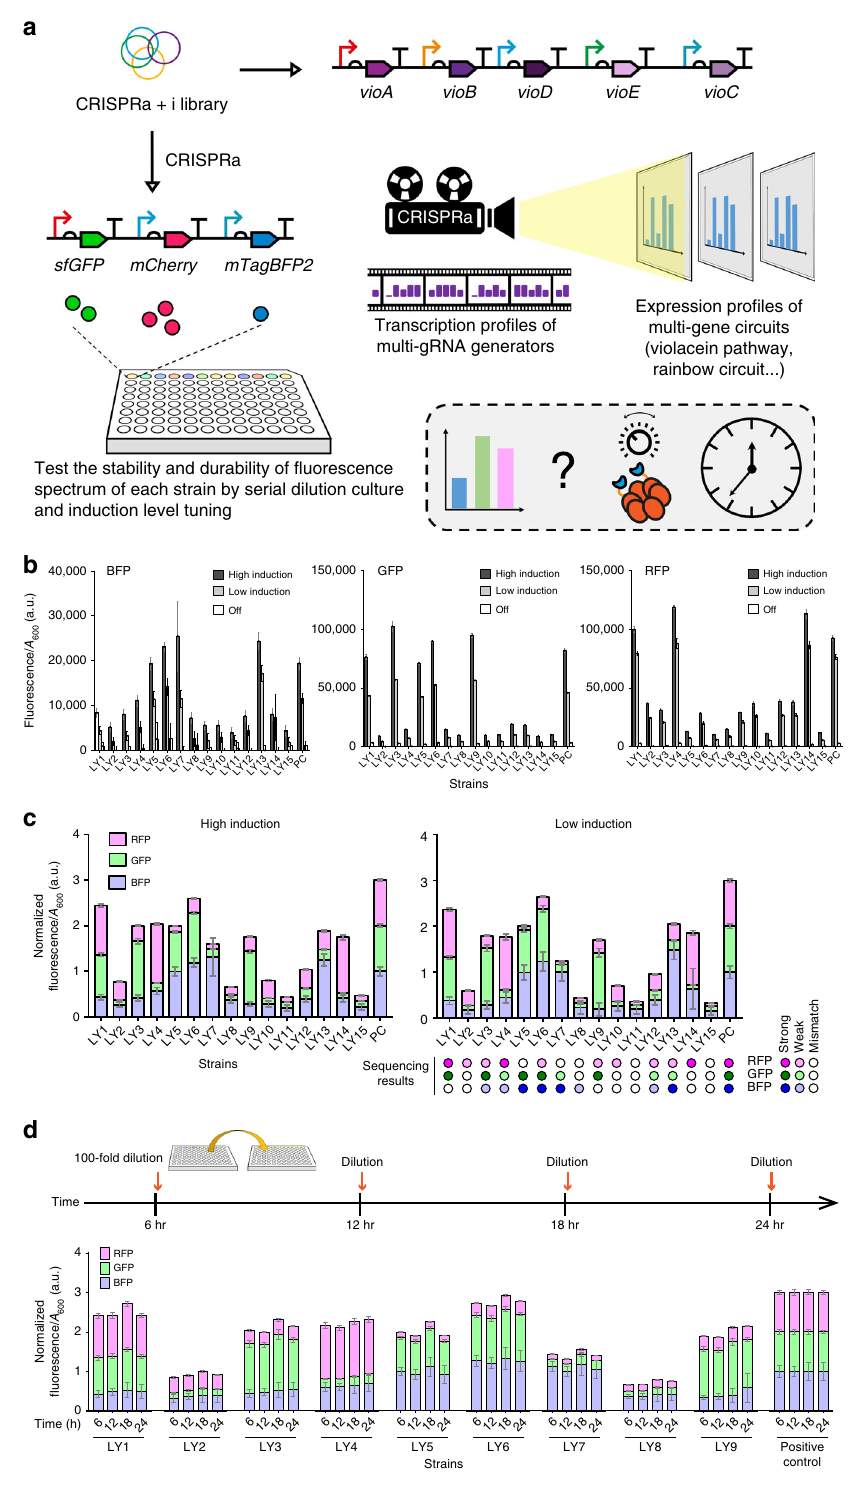
steps: First, basic sgRNA generator units with three components were built, each includes an upstream terminator, an Anderson promoter and the sgRNA sequence. The upstream terminator, with Bbs I restriction sites that would create unique overhangs (Supplementary Data 1), and Anderson promoters with different strength were made by annealing synthesized oligonucleotides. They were then ligated upstream to an ampli fi ed and digested sgRNA sequence on the vector pSB1K3 56 (sgRNA fragments were digested by Xba I and Pst I). Second, sgRNA generator units that contain an identical spacer but different promoters (BBa_J23100 /BBa_J23108 /BBa_J23114) 27 were mixed in equimolar ratios to give one set of sgRNA generator